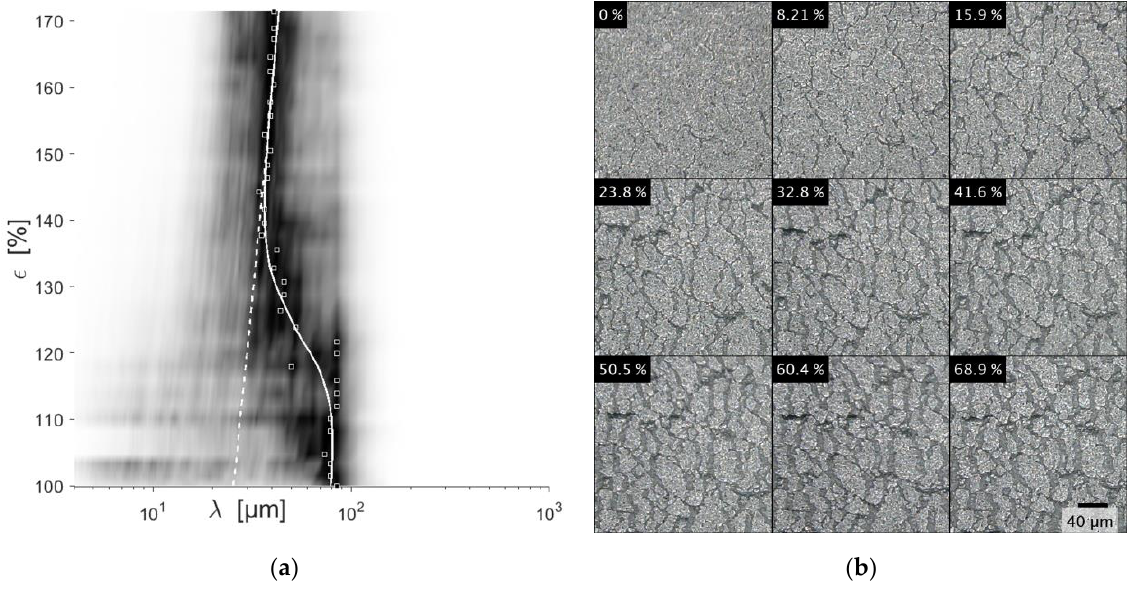
Figure 5. DLC coating on an unstructured substrate, showing the same section at different strains ( b ) and the corresponding SPD ( a ). The dotted white line highlights the measured strain. The solid white line is a logistic curve fitted to the maximum SPD values at each strain. It asymptotically approaches the measured strain. The SPD is normalized, and the contrast is enhanced by taking the fourth power. The maximum SPD value is marked by the squares.